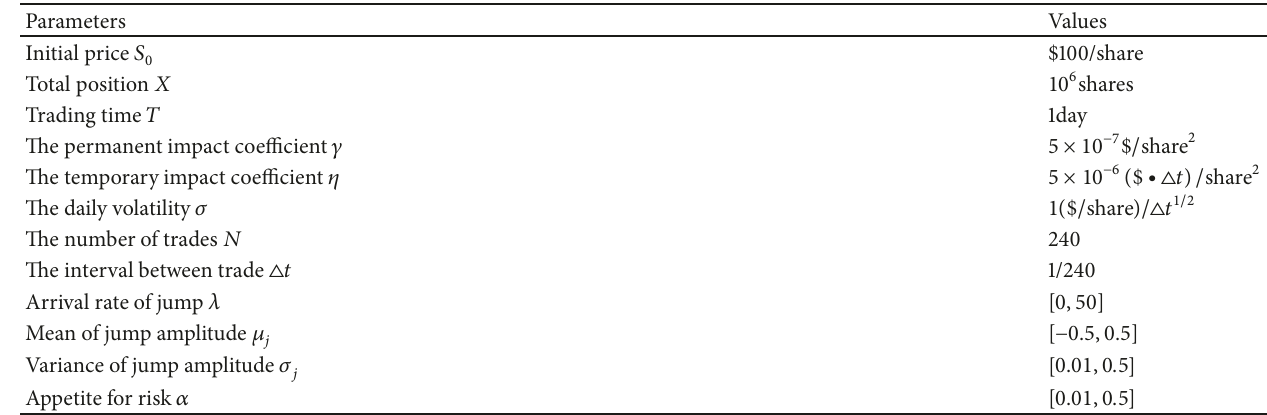
Table 1: Simulation